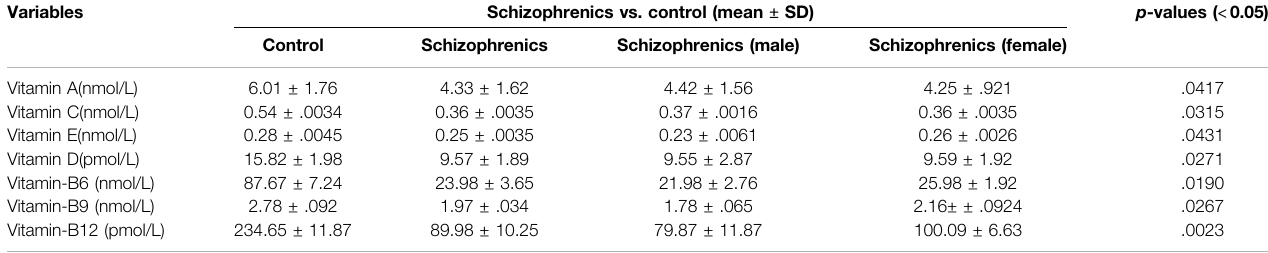
TABLE 6 | Vitamin pro fi les of schizophrenics versus controls. Variables